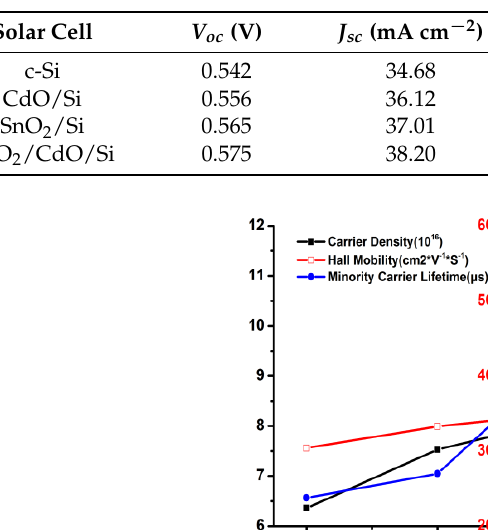
Table 1. Photovoltaic performance parameters of blank c-Si solar cell and as-synthesized CdO/Si and SnO 2 /Si SLSCs and SnO 2 /CdO/Si DLSC.